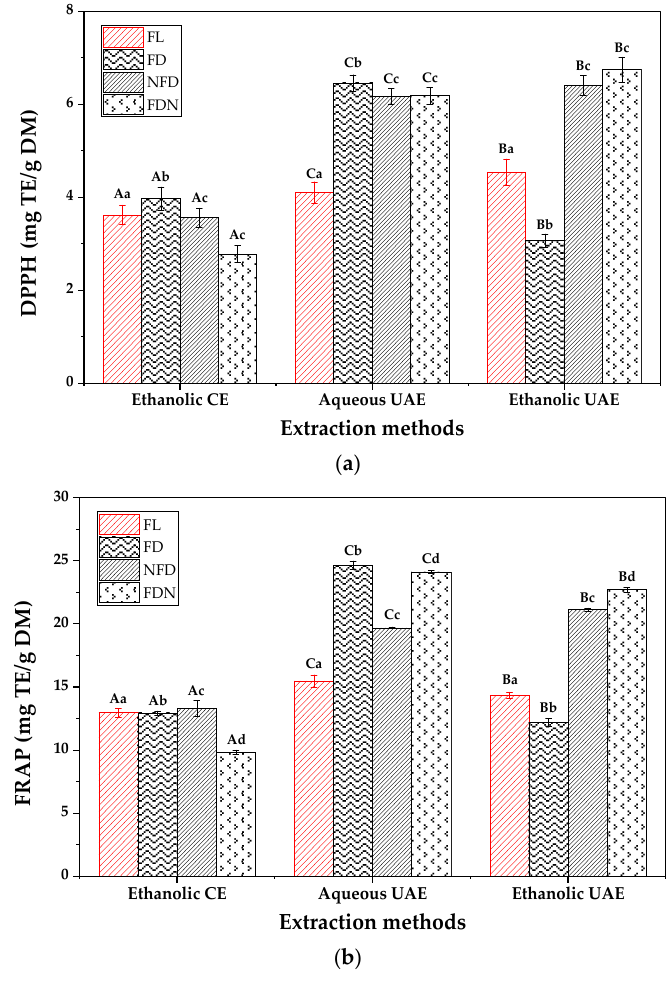
Figure 5. DPPH ( a ) and FRAP ( b ) of phenolic extracts obtained from SBLs. Data are presented as mean ± SD ( n = 3). Different capital letters indicate significant difference in the extraction method, and different small letters indicate significant difference in the sample preparation method ( p ≤ 0.05), according to two-way ANOVA and Tukey’s HSD